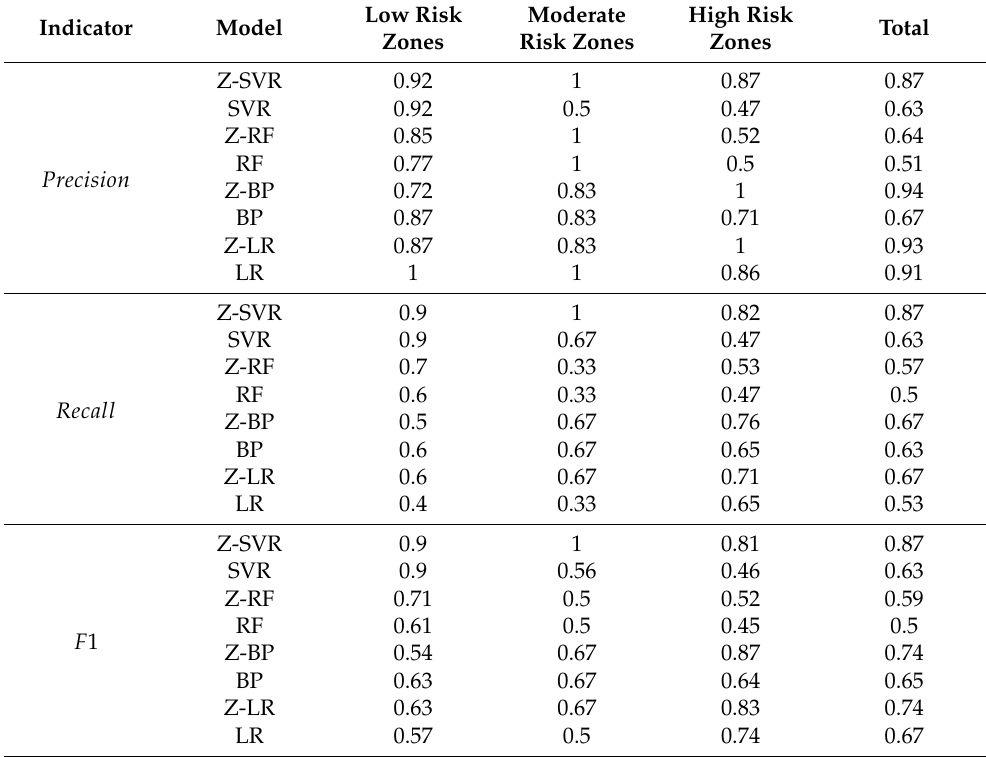
Table 7. Comparison of classification performance between Z-SVR and other models for three degrees of risk